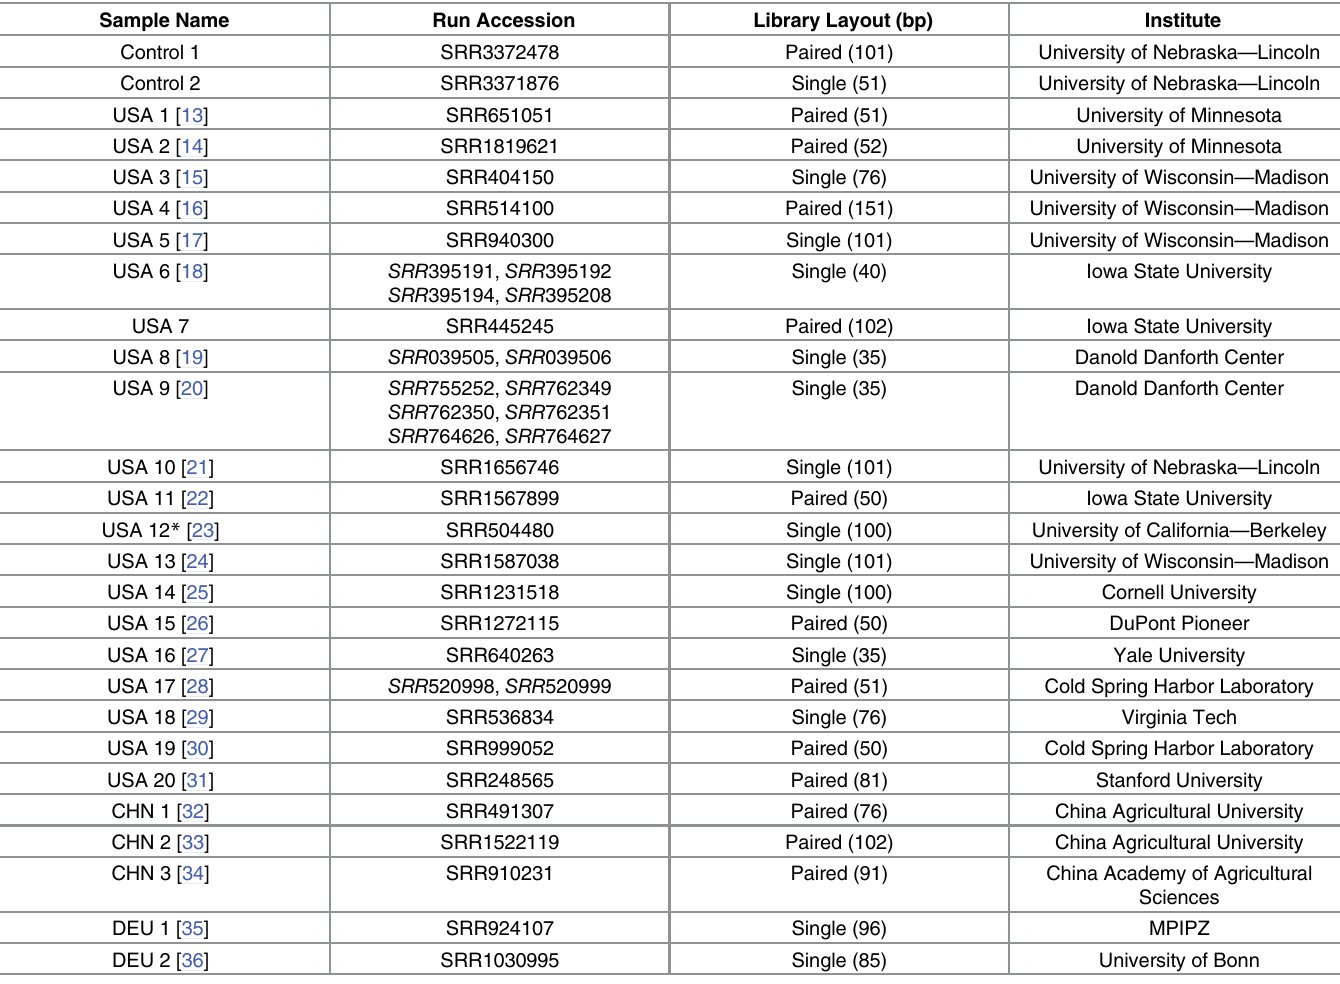
Table 1. B73 RNA-seq data sets